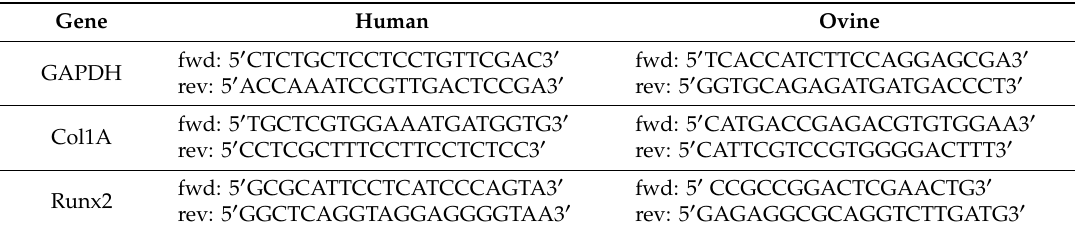
Table 1. Real-time polymerase chain reaction (RT-PCR). Primers used for the relative osteogenic gene expression of Col1A and Runx2 in hMSCs and